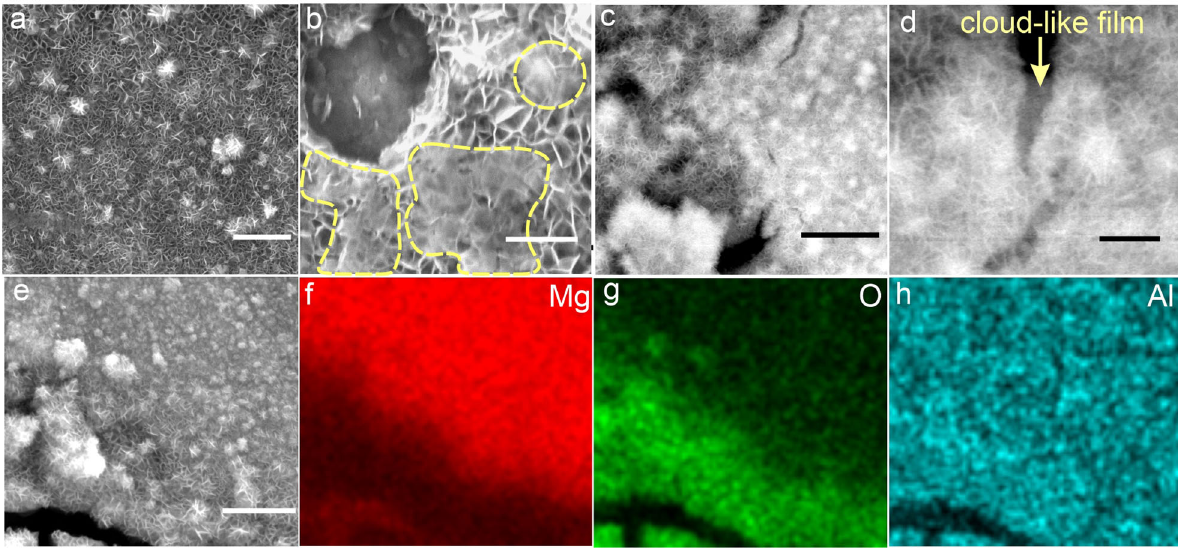
Fig. 3 Electron microscopy observation of alloy surface after immersion in 0.1 M NaCl. a , b SE-SEM image of surface without localised corrosion and c , d BSE-SEM image of surface area with localised corrosion, and e – h SE and corresponding EDXS mapping at the interface between intact area and corroded area. Dashed curves in ( b ) and arrow in ( d ) show the electron-beam transparent fi lm. Scale bars in a , b , c , d , and e indicate 1 µm, 400 nm, 2 µm, 500 nm, and 2 µm,